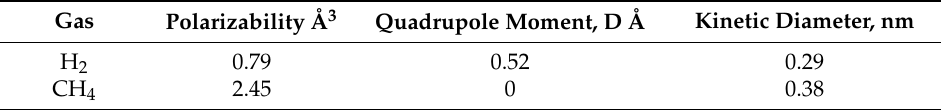
Table 1. Molecular properties of adsorbed